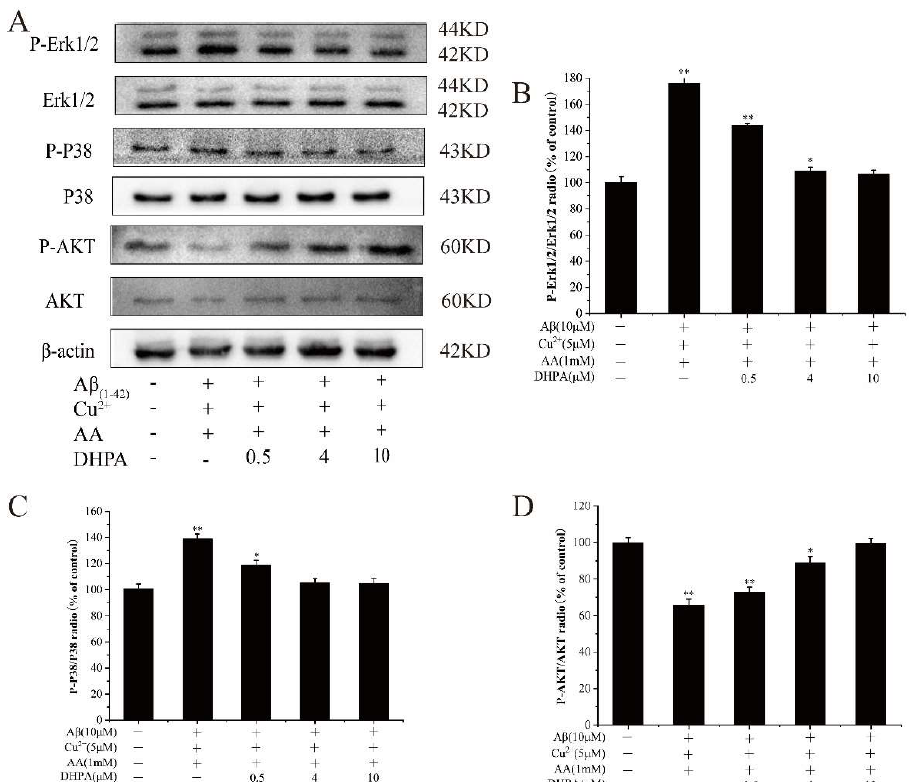
Figure 6. Effects of DHPA on the phosphorylation of MAPKs and AKT in A β (1–42) /Cu 2+ /AA-induced SH-SY5Y cells. ( A ) Representative Western blot were shown for P-Erk1/2, Erk1/2, P-P38, P38, P-AKT and AKT proteins. P-Erk1/2 ( B ), P-P38 ( C ), and P-AKT ( D ) protein expressions were detected by WB analysis. * p < 0.05 and ** p < 0.01 compared to the control values.